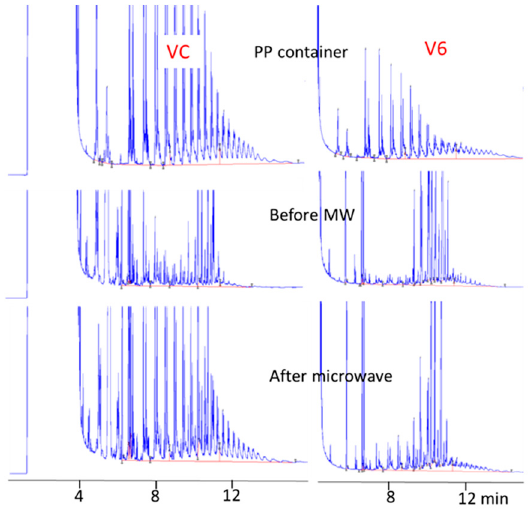
Figure 6. E ff ect of microwave Figure 6. Effect of microwave heating.